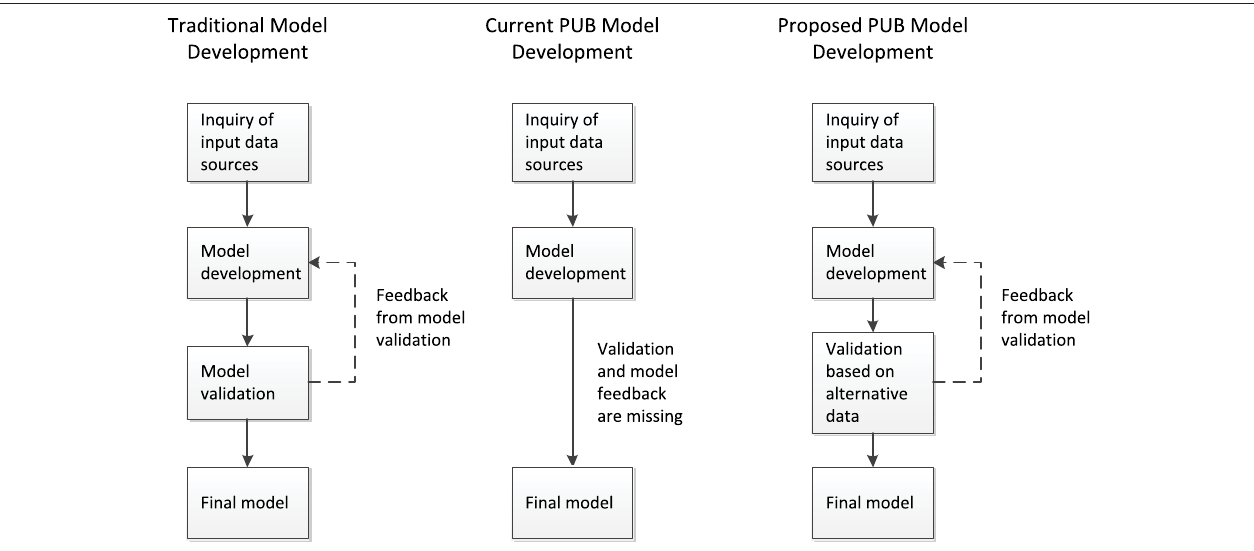
FIGURE 1 | On the left a representation of the classical model development, in the middle the common practice in PUB cases, and on the right the proposed new approach for PUB cases. Due to the absence of a validation phase, the iterative model improvement is removed in most PUB cases, which makes the model much more sensitive for model errors and generally results in a sub-optimal